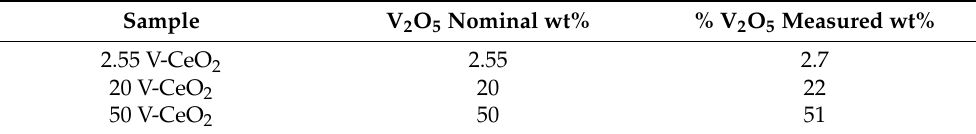
Table 3. Theoretical and measured vanadium content of the catalysts before the sulfuration.